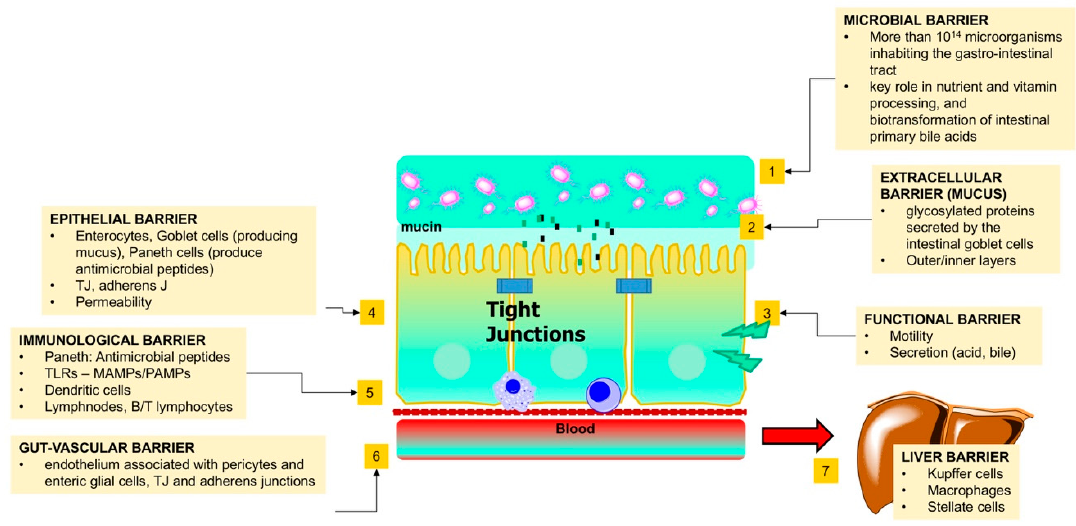
Figure 5. Components of the physiological gut barrier. The number of microorganisms inhabiting the gastro-intestinal tract has been estimated to exceed 10 14 . Starting from the gut lumen, we observe microbes (1) in the most superficial layer of the mucous (2). The functional barrier (3) includes the role of gastrointestinal motility ad secretion of gastric acid and bile the epithelial barrier (4) is composed by the collection of gut cells and tight junctions. The immunological barrier (5) includes antimicrobial peptides, toll-like receptors, microbial- (MAMPs) and pathogen- (PAMPs) associated molecular patterns, and B / T lymphocytes. The gut vascular barrier (6) and the ultimate liver barrier (7) are depicted, as well. Adapted from Nicoletti et al. [91].